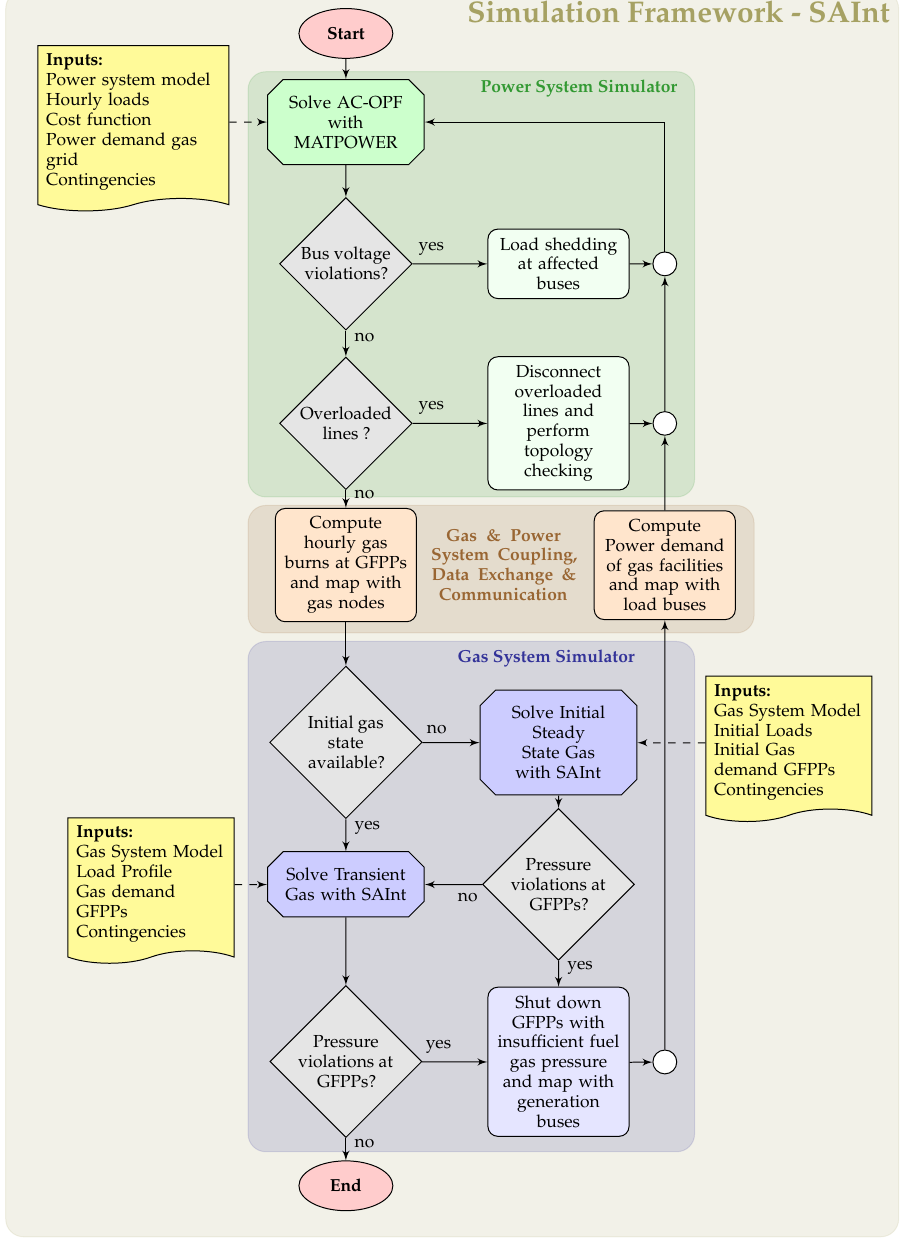
Figure 3. Flow chart of the proposed Simulation Framework SAInt, showing the implemented